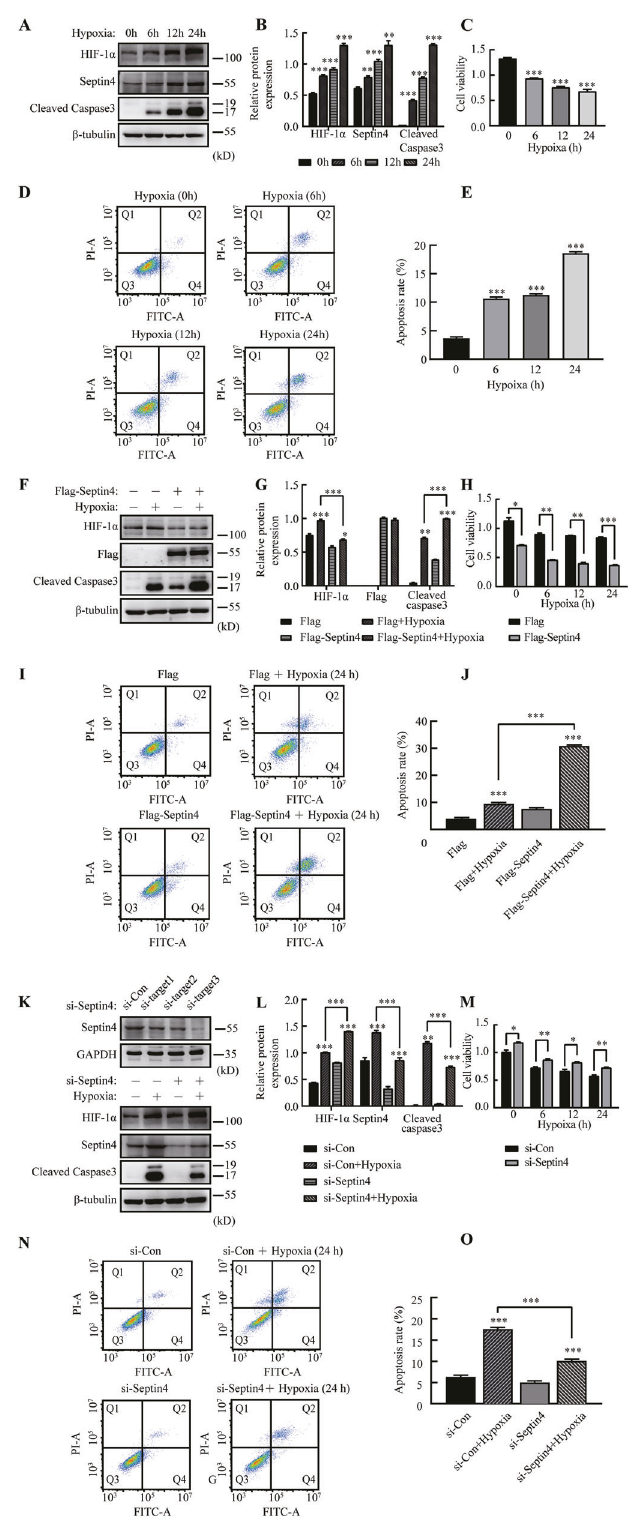
(Fig. 1K) signi fi cantly alleviated hypoxia-induced H9c2 apoptosis